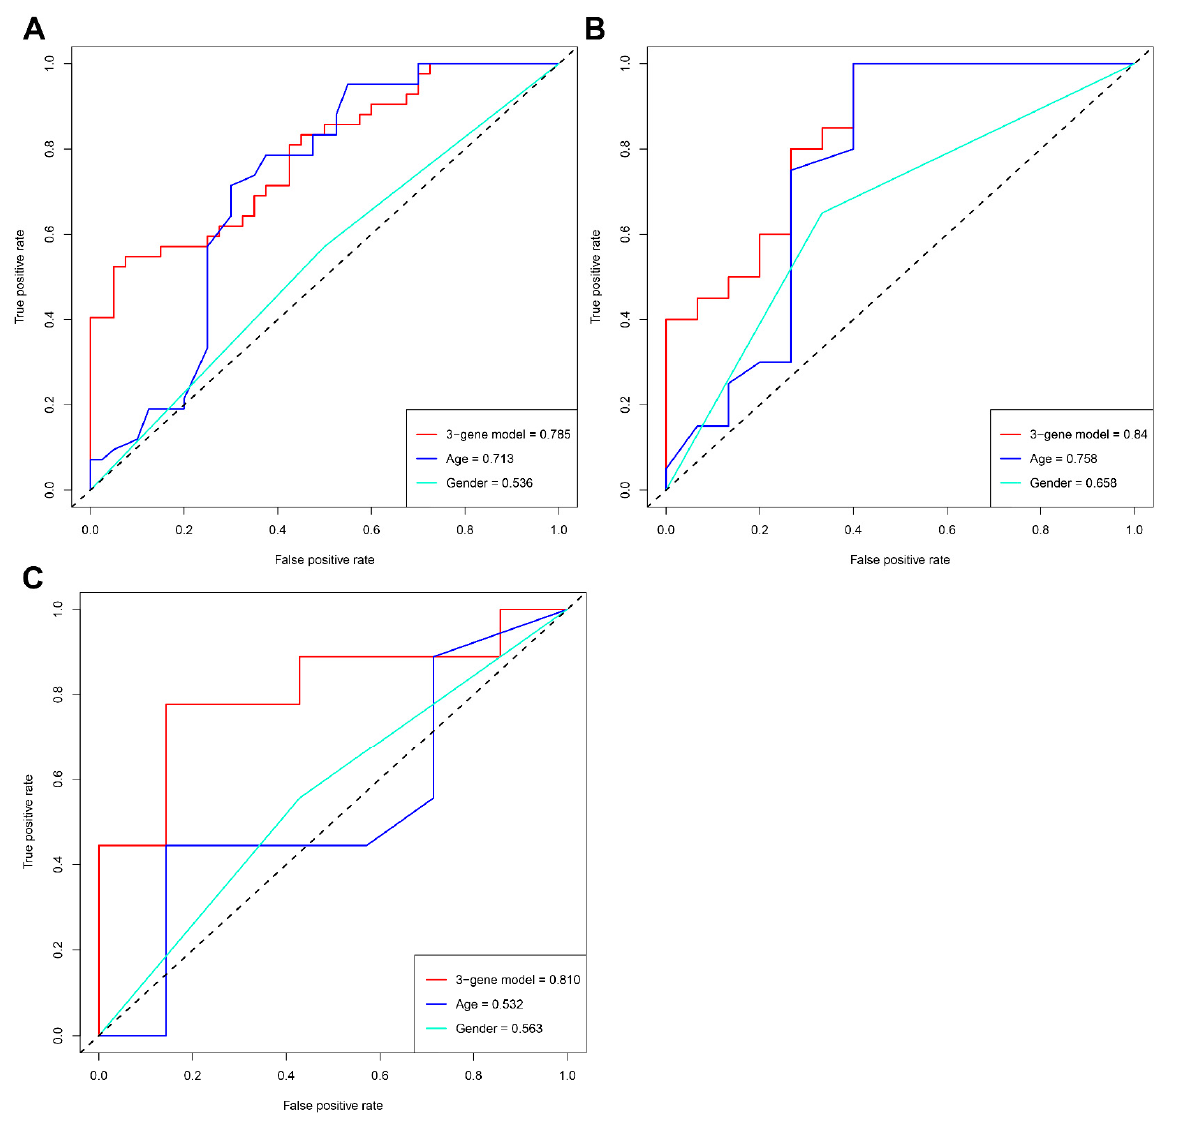
Figure 5. Comparing the differences of our classifier with demographic characteristics. ROC curves of the 3-gene model, age, and gender in the training ( A ), test ( B ), and validation set ( C